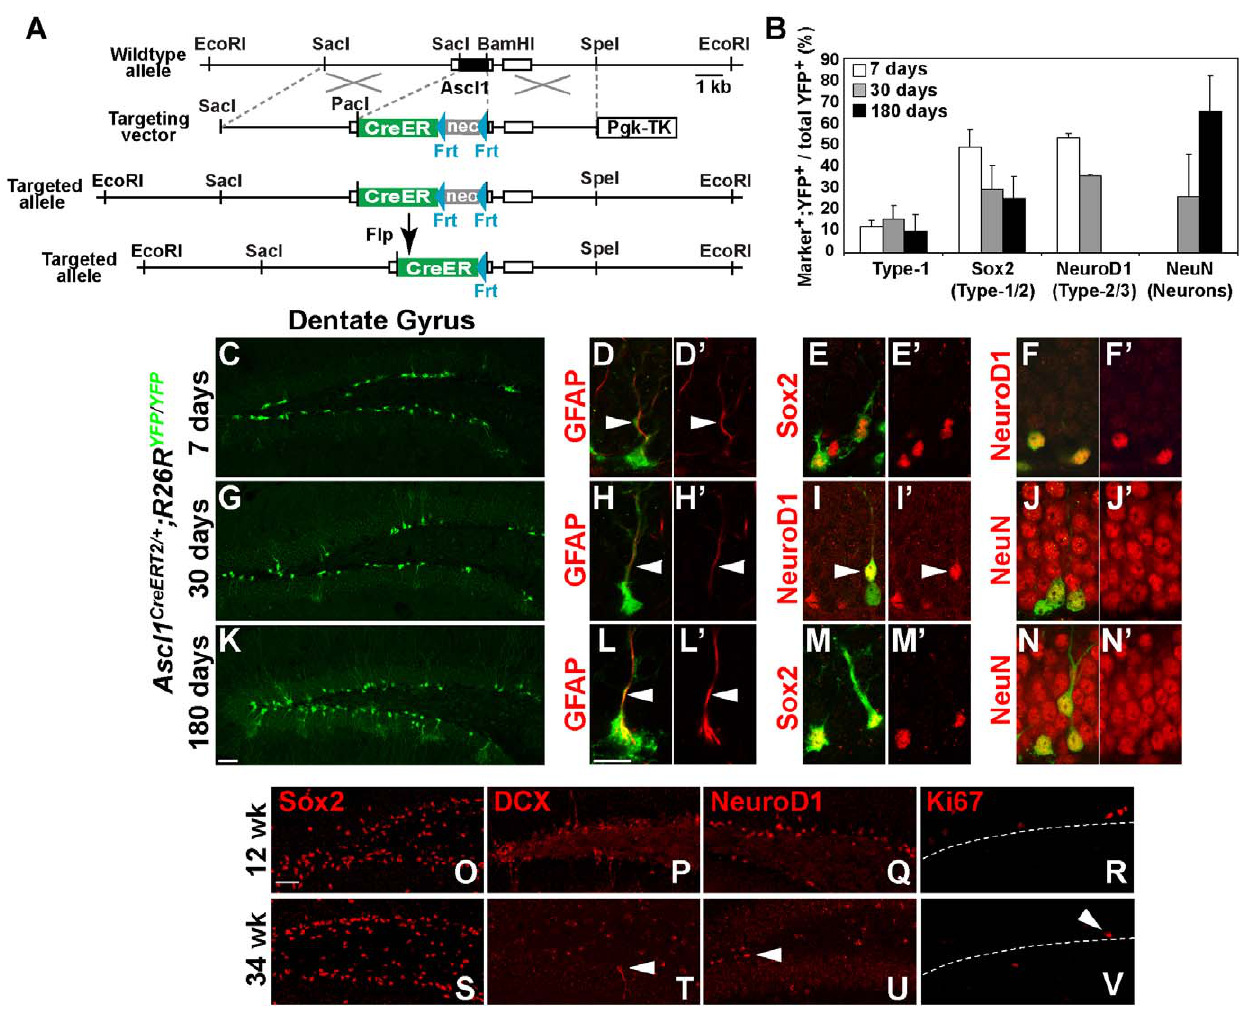
Figure 2. A subset of Ascl1 lineage cells continue to produce new granule neurons 30 days after initial Ascl1 expression in adult hippocampus. (A) Targeting strategy for Ascl1 CreERT2/ + knock-in mice. (B) Quantification of the percentage of YFP + cells co-labeled with stage-specific markers in hippocampus of adult Ascl1 CreERT2/ + ;R26R YFP/YFP mice 7, 30, or 180 days post-TAM. 150–500 YFP + cells per mouse were counted for each marker, n=2 Ascl1 CreERT2/ + ;R26R YFP/YFP mice per time point. (C–F 9 ) 7 days post-TAM YFP + cells co-express GFAP (and have Type-1 morphology), Sox2, or NeuroD1, but not NeuN. (G–J 9 ) 30 days post-TAM YFP + cells overlap with NeuN, but also can co-express GFAP or NeuroD1. (K–N 9 ) 180 days post- TAM a subpopulation of YFP + cells are still Type-1 cells by morphology and express GFAP and Sox2, whereas the majority of YFP + cells express NeuN but not NeuroD1. (O–V) Neurogenesis in the SGZ dramatically decreases between 12 weeks and 34 weeks of age as seen in the decrease in DCX (P,T), NeuroD1 (Q,U) and Ki67 (R,V). Arrowheads indicate the few cells positive for these markers in the 34 week old mice. Notably, Sox2 does not decrease (O,S) so may label quiescent Type-1 like cells. Scale bars =50 m m (C,G,K), 10 m m (D–F 9 , H–J 9 , I–V).